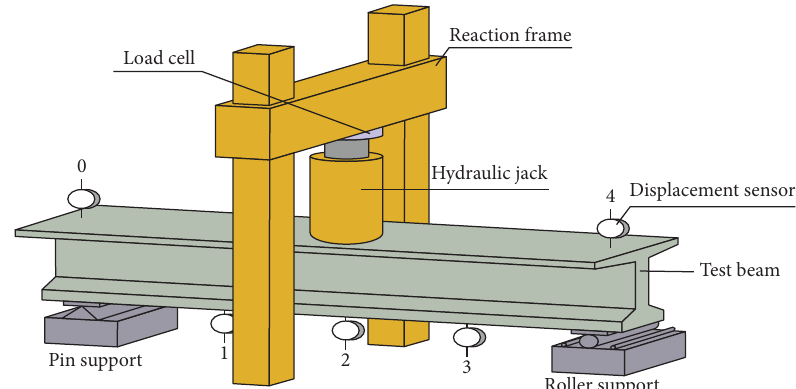
Figure 11: Experimental device and